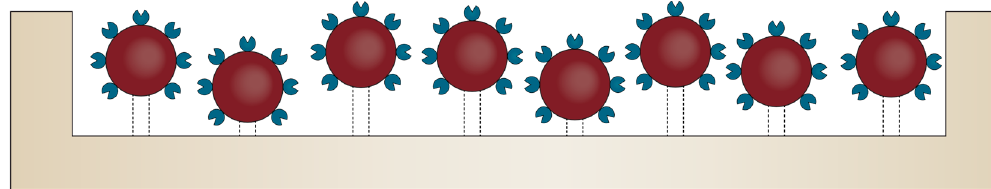
Figure 3. Schematic representation of the use of bioreceptor-functionalized nanomaterials deposited onto the surface of the microfluidic chip.